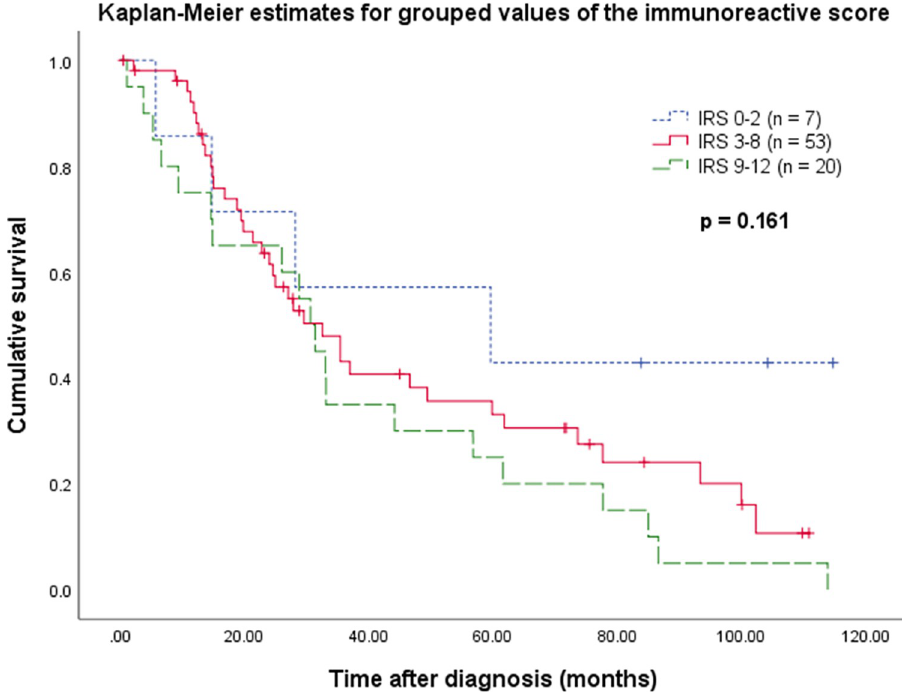
Fig 2. Overall survival concerning CA XII expression within a stratified subgroup of OC patients. Censoring events have been marked in the graph.